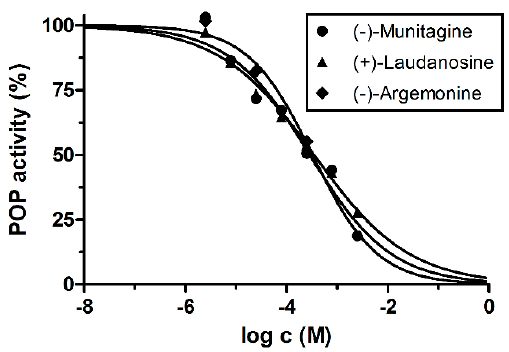
Figure 3. The dose-response curves of the most potent POP inhibitors (–)-munitagine, (+)-laudanosine and (–)-argemonine (calculation of their IC 50 values).